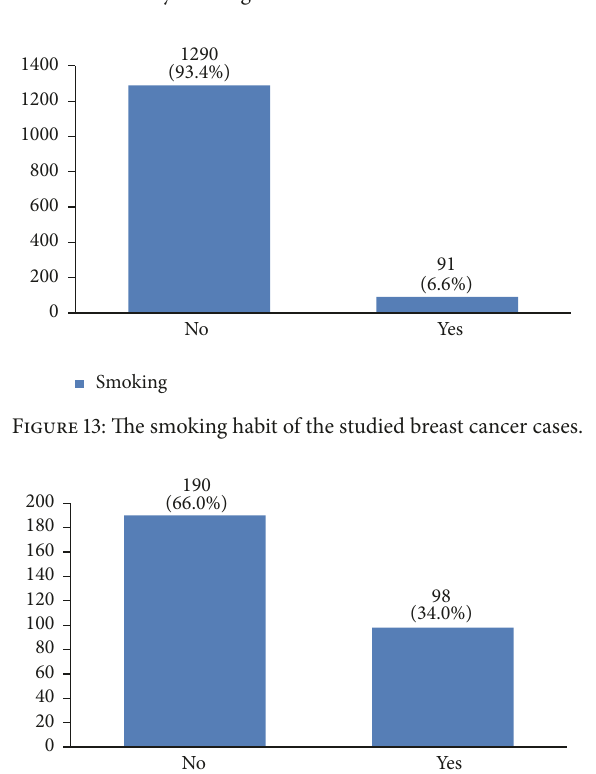
Figure 16: The surgery type of the studied breast cancer cases.